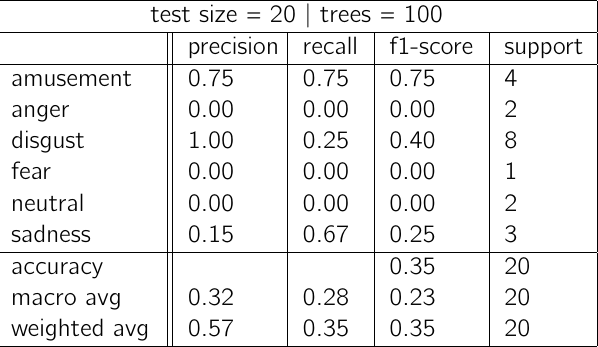
Table 2: Results using the CWT treated EDA data with test size = 20 and trees = 100.